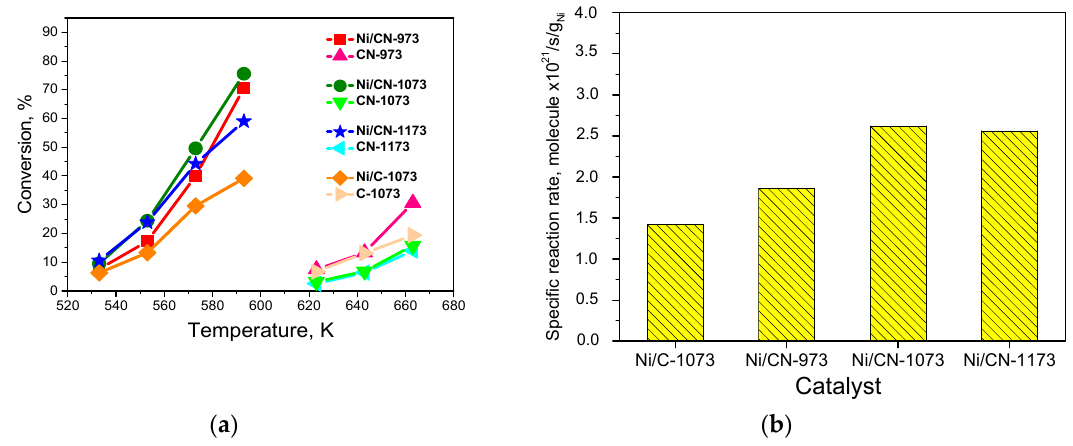
Figure 6. ( a ) Dependences of the formic acid decomposition conversions on temperature for the Ni catalysts (7 mg) and carbon supports (4 mg) and ( b ) dependence of the specific reaction rates for the Ni catalysts at 553 K.